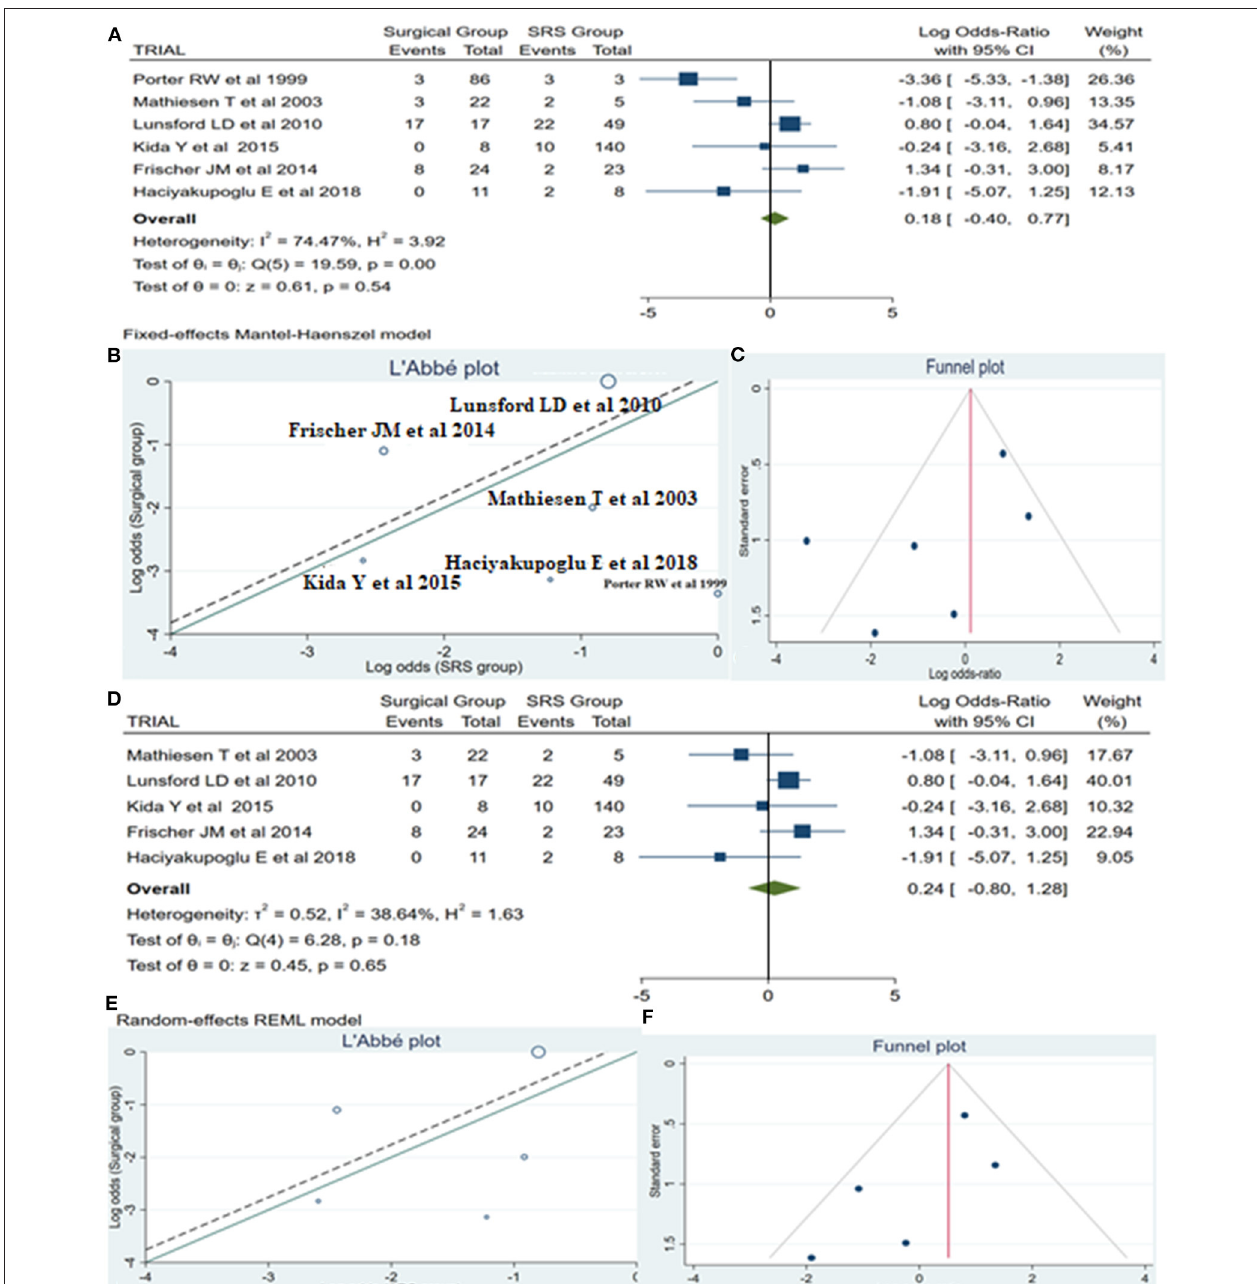
FIGURE 3 | Rebleeding (ReBl): (A) OR forest plot ReBl: Results demonstrate no statistically significant difference between the two groups [decimal logarithm of odd ratio—log OR 0.18, CI 95% − 0.40 to 0.77, and p = 0.54]; (B) L’Abbé plot and analysis of heterogeneity ( p < 0.1 and I 2 = 74.47%); (C) Funnel plots for publication bias on the available evidence relevant to BSCMs management; (D) OR forest plot ReBl without “Porter RW” (11) article: Results demonstrate no statistically significant difference between the two groups (log OR 0.24, CI 95% − 0.80 to 1.28, and p = 0.65); (E,F) L’Abbé and funnel plots demonstrated very low heterogeneity ( p = 0.18 and I 2 = 38.64%) and no publication bias of the ReBl in groups of patients with BSCMs, respectively. SRS, Radiosurgical group; I 2 shows the percentage of total variation across studies that is due to heterogeneity rather than chance; CI, confidence interval.